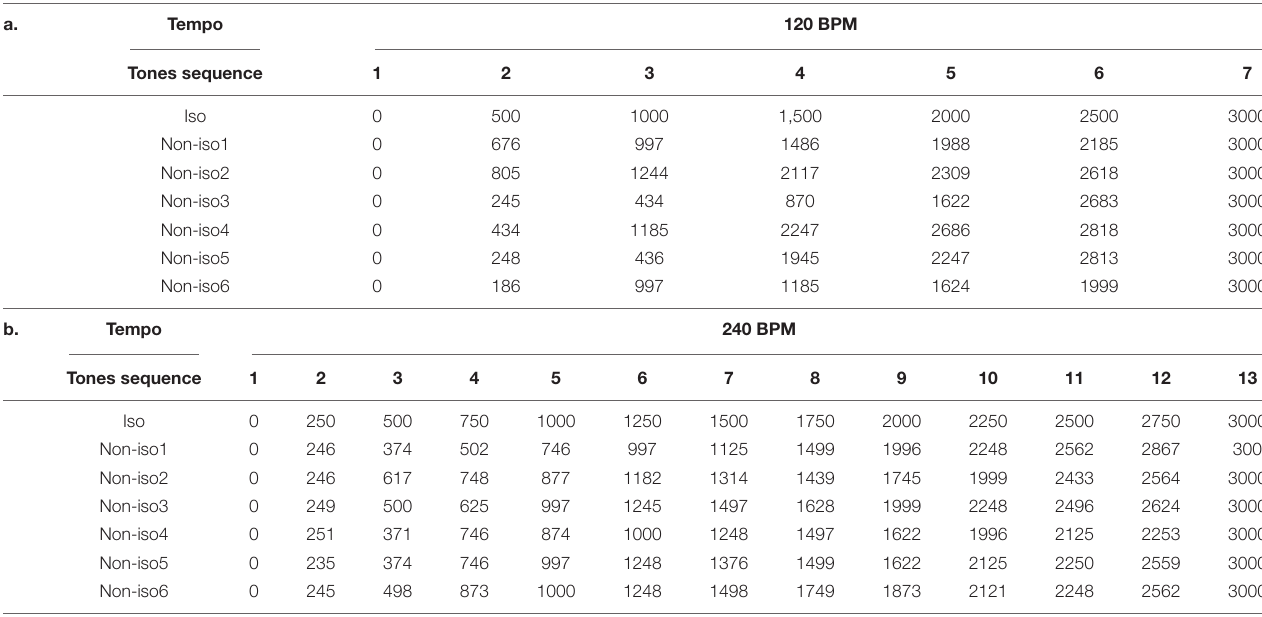
TABLE 1 | Description of onsets (in ms) in isochronous (iso) and non-isochronous (non-iso) tones sequences, for the 120 (a., i.e., a total of 7 tones) and 240 BPM tempi conditions (b., i.e., a total of 13 tones).